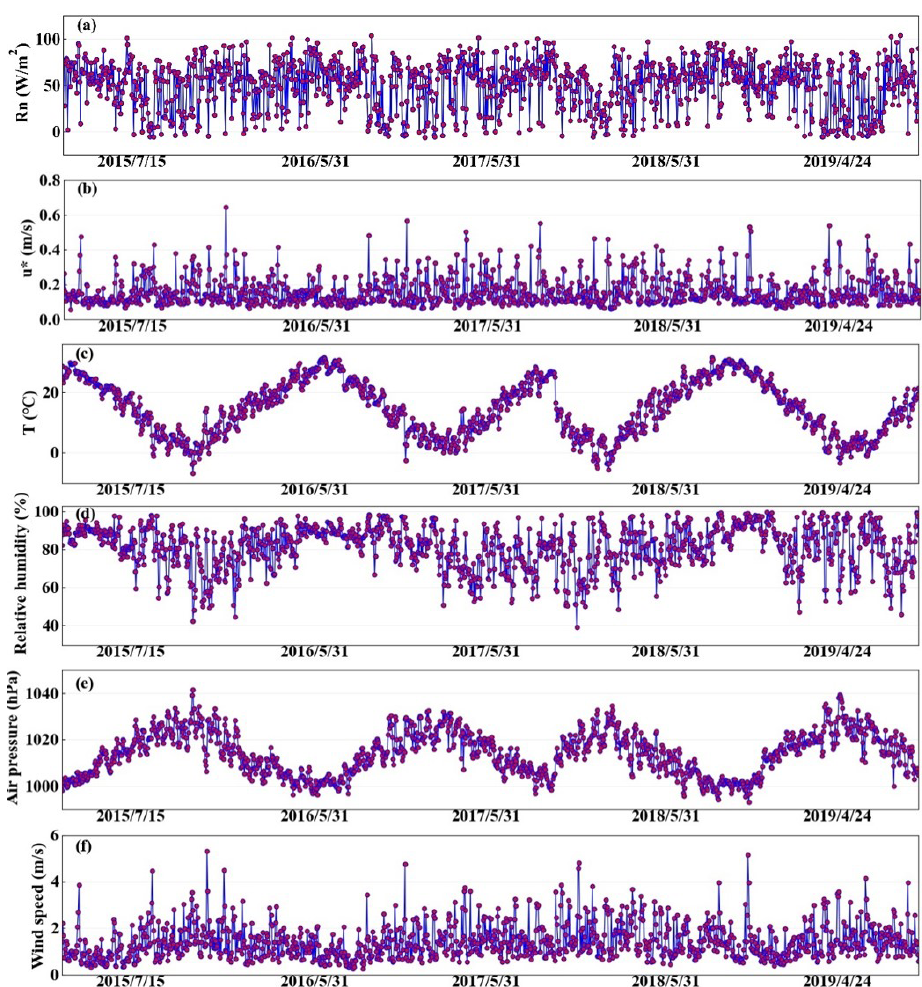
Figure 3. Daily averaged (a) R n : net radiation (Wm − 2 ) , (b) u ∗ : friction velocity (ms − 1 ), (c) T : air temperature ( ◦ ), (d) RH: relative humidity (%), (e) P : air pressure (hPa), and (f) WS: wind speed (ms − 1 )